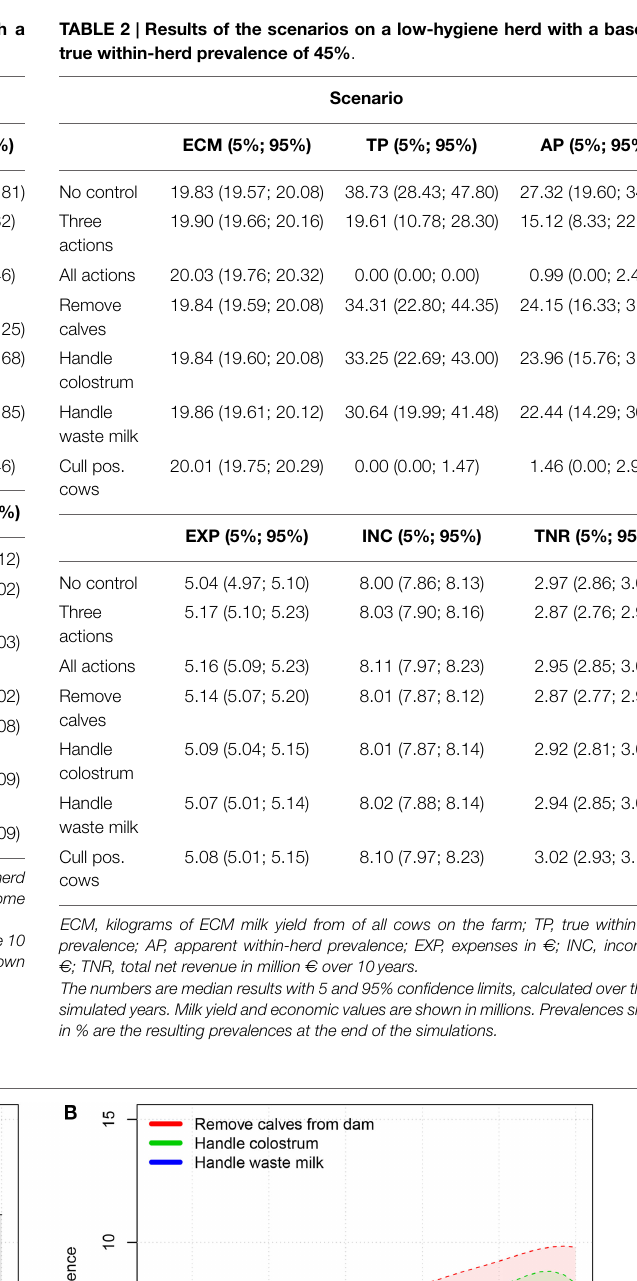
Frontiers in Veterinary Science |